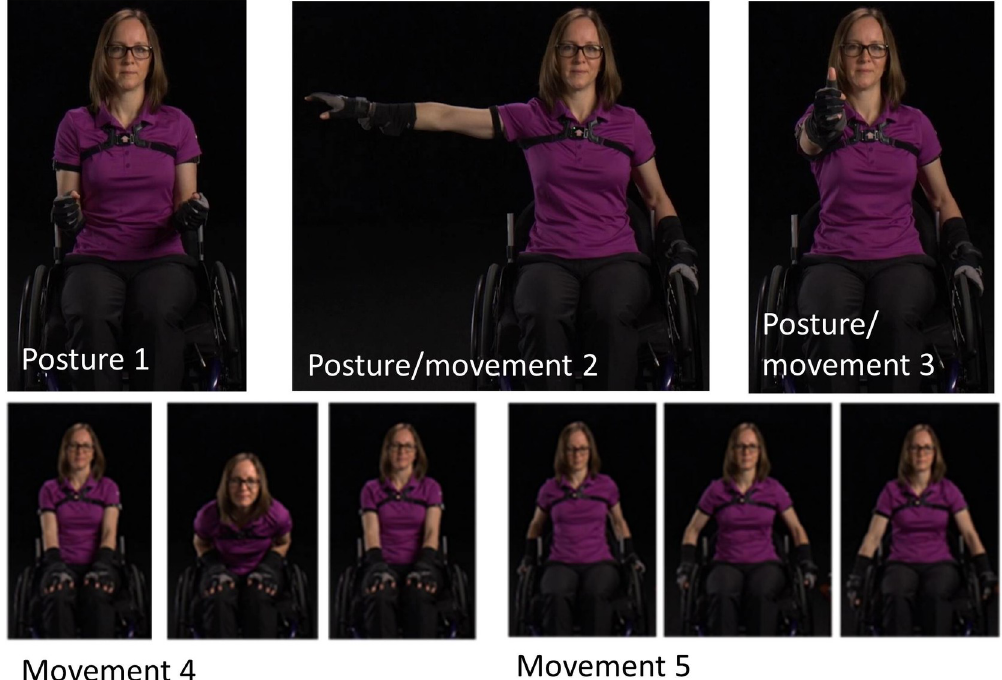
Fig 1. Functional calibration used to align IMU’s with the body. Postures included static upright neutral posture with upper arms resting against the thorax (posture 1), static and dynamic arm t-pose/movement (shoulder abduction = 90˚, posture 2), static and dynamic flexion pose/movement (shoulder flexion = 90˚, posture 3), dynamic flexion and extension of the torso (movement 4), and simulated wheelchair use or walking (movement 5). Postures 2 and 3 were completed for both the right and left arms separately. (Note: The individual pictured is a co-author who is